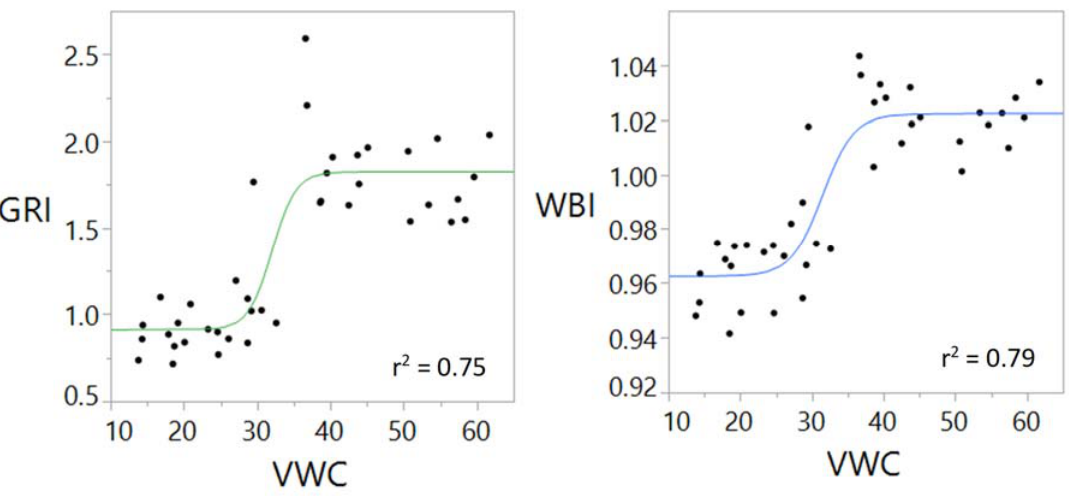
Figure 5. Nonlinear four parameter logistic regression for the green-to-red ratio index (GRI) and the water band index (WBI) compared to soil volumetric water content (VWC) for 12 July 2018.